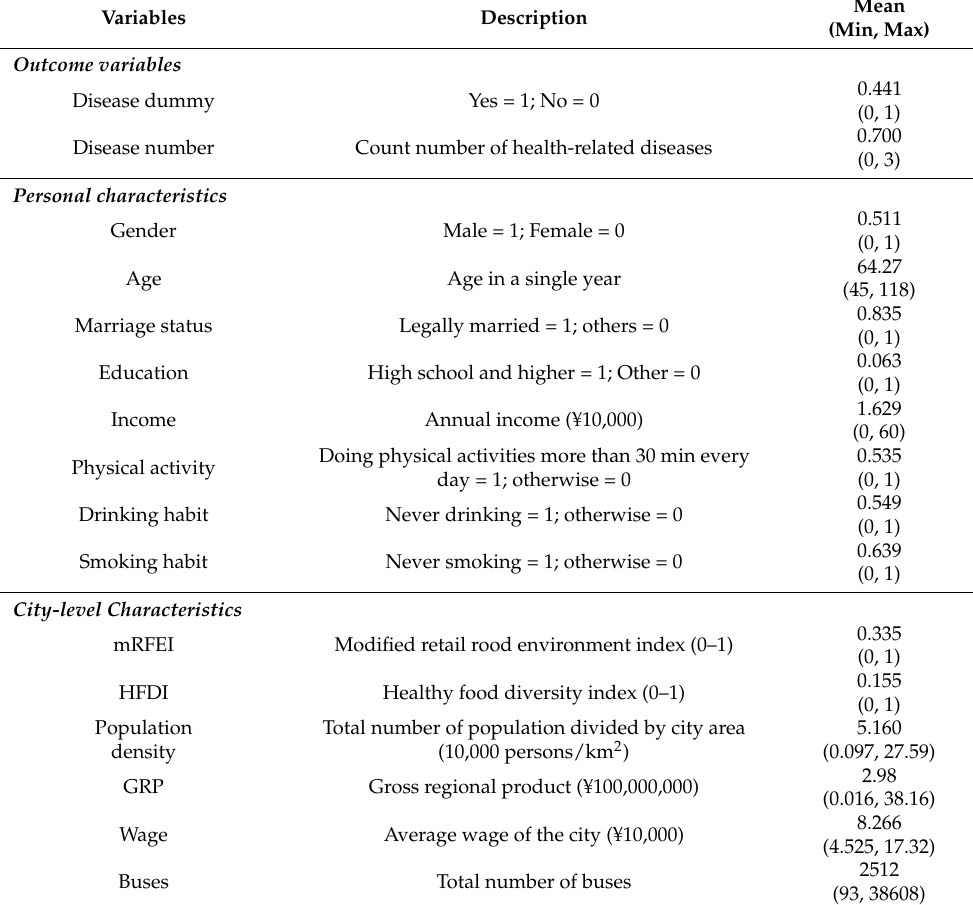
Figure 1. Spatial distribution of mRFEI and HFDI for sample cities. Table 2. Descriptive statistics of the